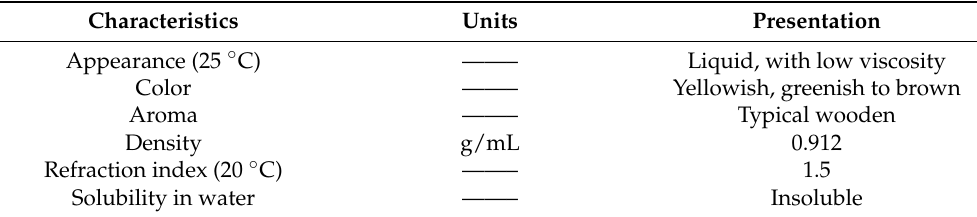
Table 1. Technical specifications of commercially purchased copaiba oil.